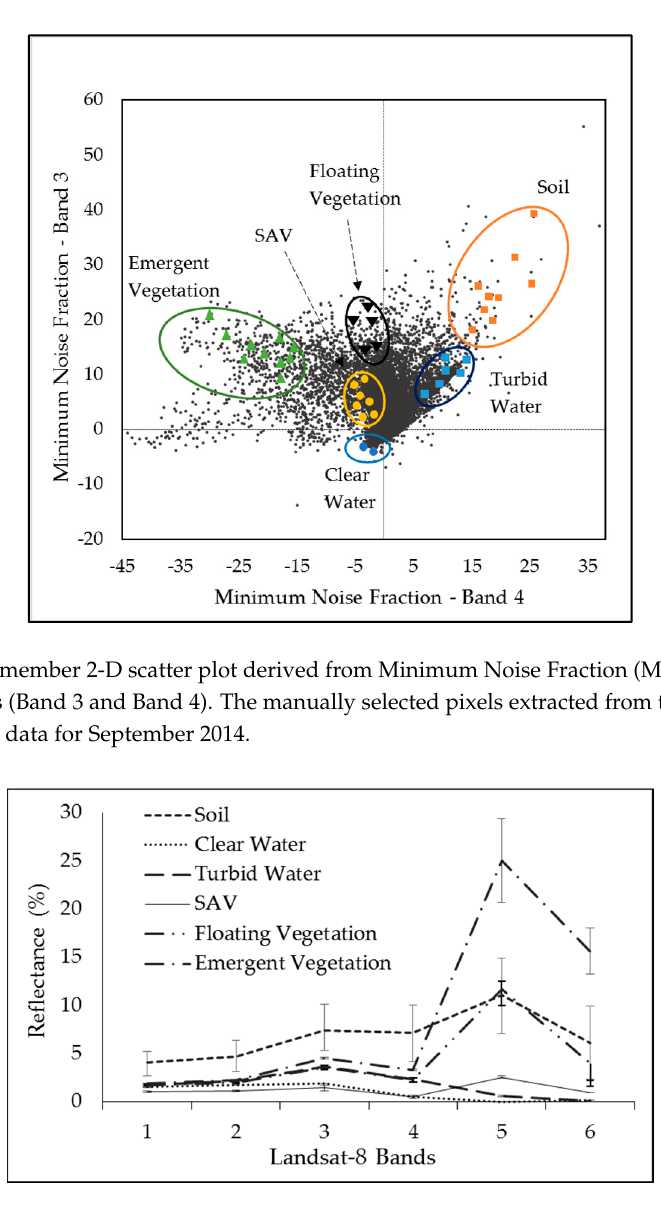
Figure 6. Endmember spectra extracted from Landsat-8 imagery (i.e., mean of the manually selected pixels) using the ground reference data from September 2014.